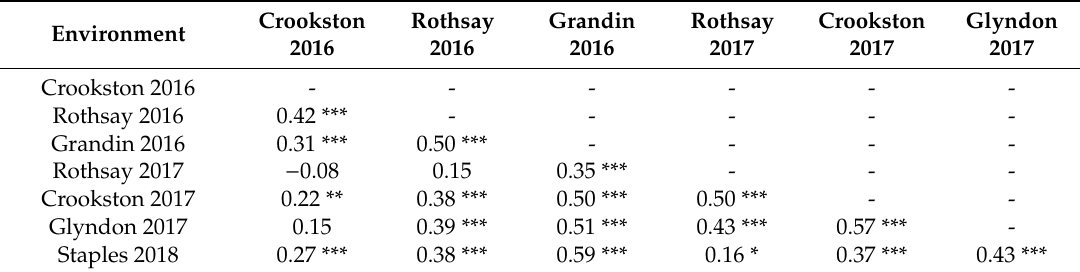
Table 2. Spearman rank correlations ( ρ ) between Phomopsis stem canker disease incidence scores in the HA 89 / HA-R3 recombinant inbred line population tested in multiple environments during 2016 to